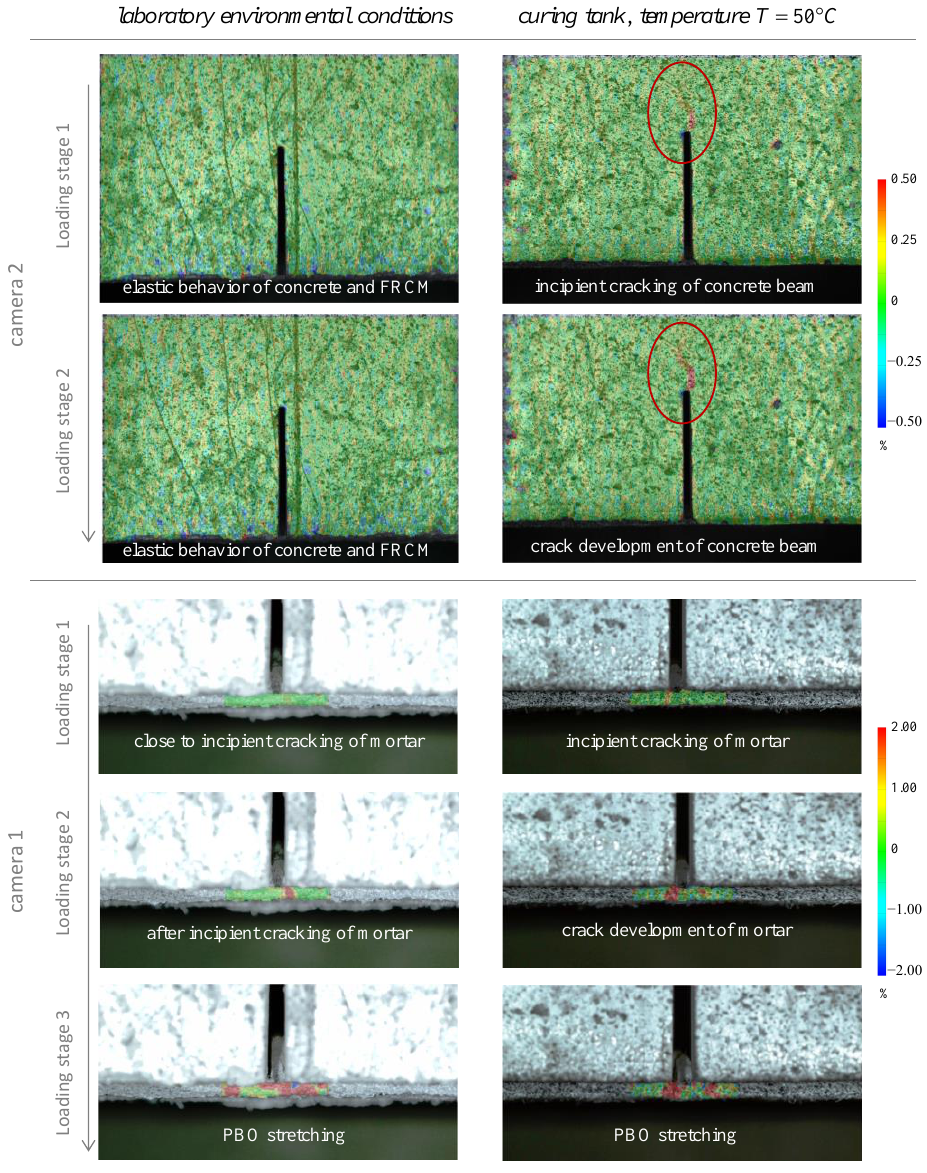
Figure 13. Comparison of DIC-processed images of longitudinal strains in the notched concrete beams under two different curing conditions.